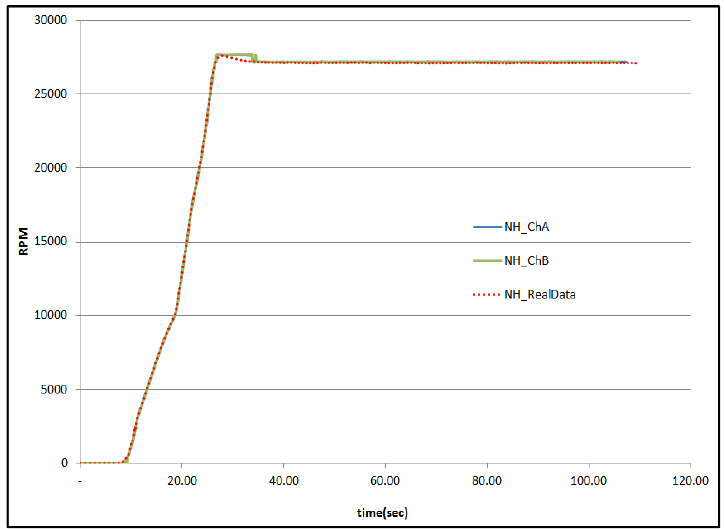
Figure 9. Result of startup phase performance test (NH).